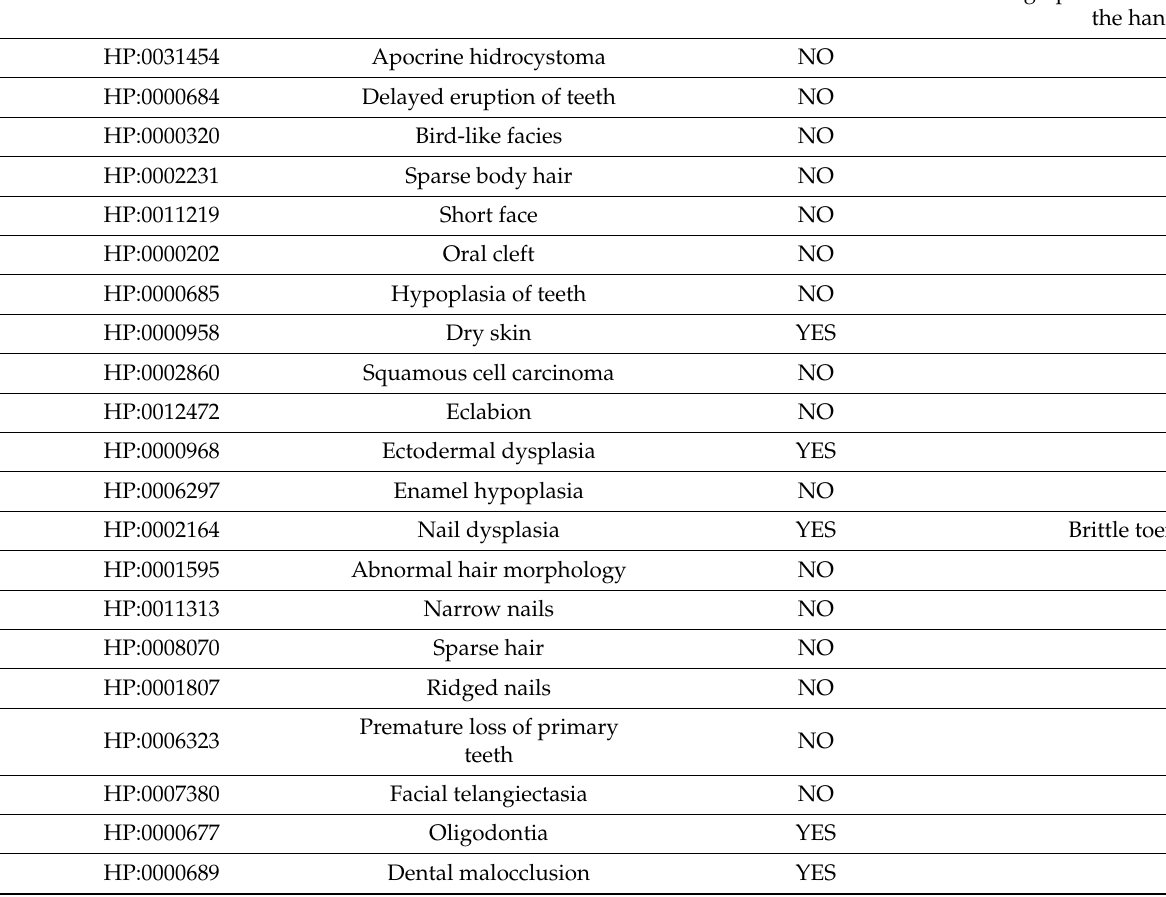
Multiple hyperpigmented lentiginous macules <5 mm on the upper back and buttocks. Appearance was slightly atrophic with loss of fingerprints on the thumbs of the